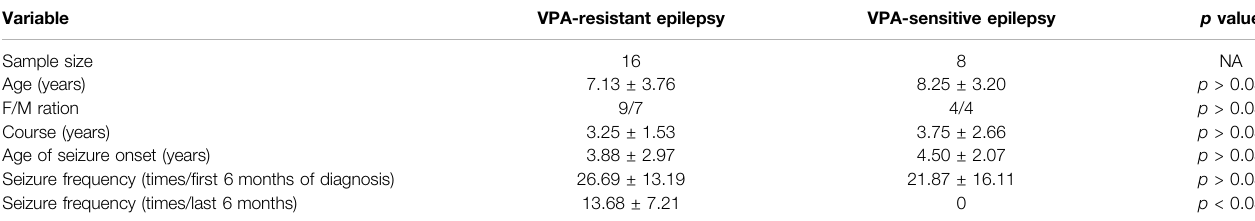
TABLE 1 | Comparison of clinical data in patients with VPA-resistant epilepsy and VPA-sensitive epilepsy.